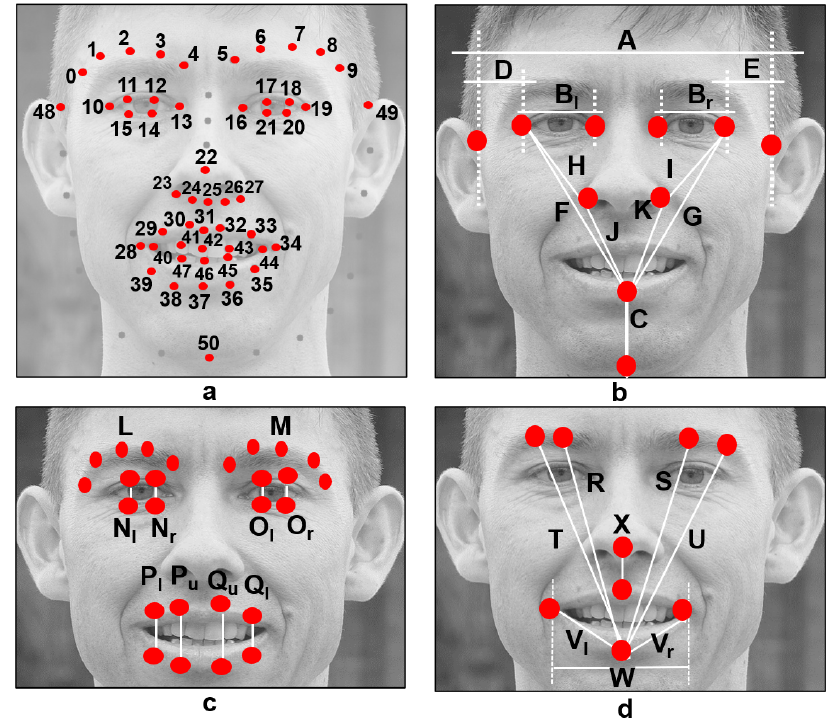
Figure 2. ( a ) The 51 key points inspired by the model proposed by Matthews and Baker [11]; ( b – d ) Facial distances to obtain spatial relations between facial landmarks